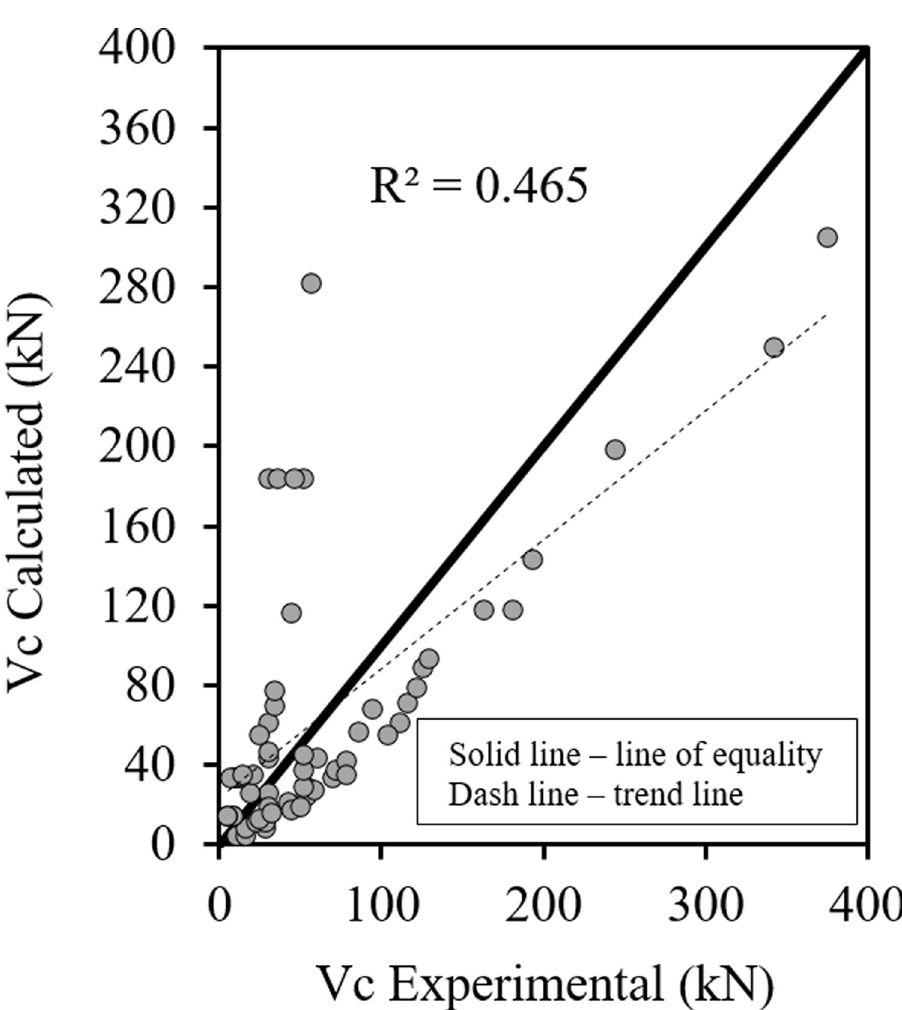
Fig 8. Shear strength of fibrous HSC beams (Eq